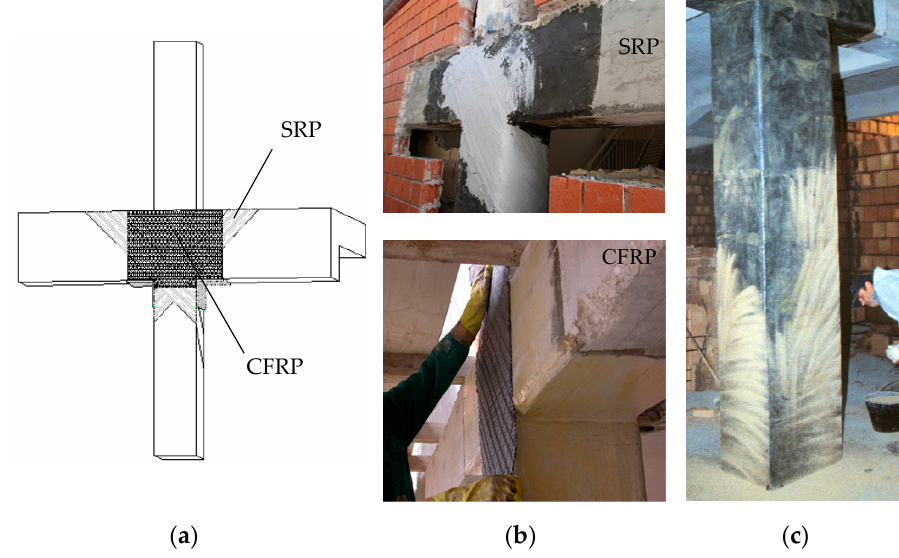
Figure 6. Local retrofit solutions for columns and joints: ( a ) application of SRP uniaxial system to withstand horizontal action due to infills and quadriaxial CFRP fabric for corner joint ( b ); and shear strengthening of the columns with uniaxial CFRP strips ( c ).